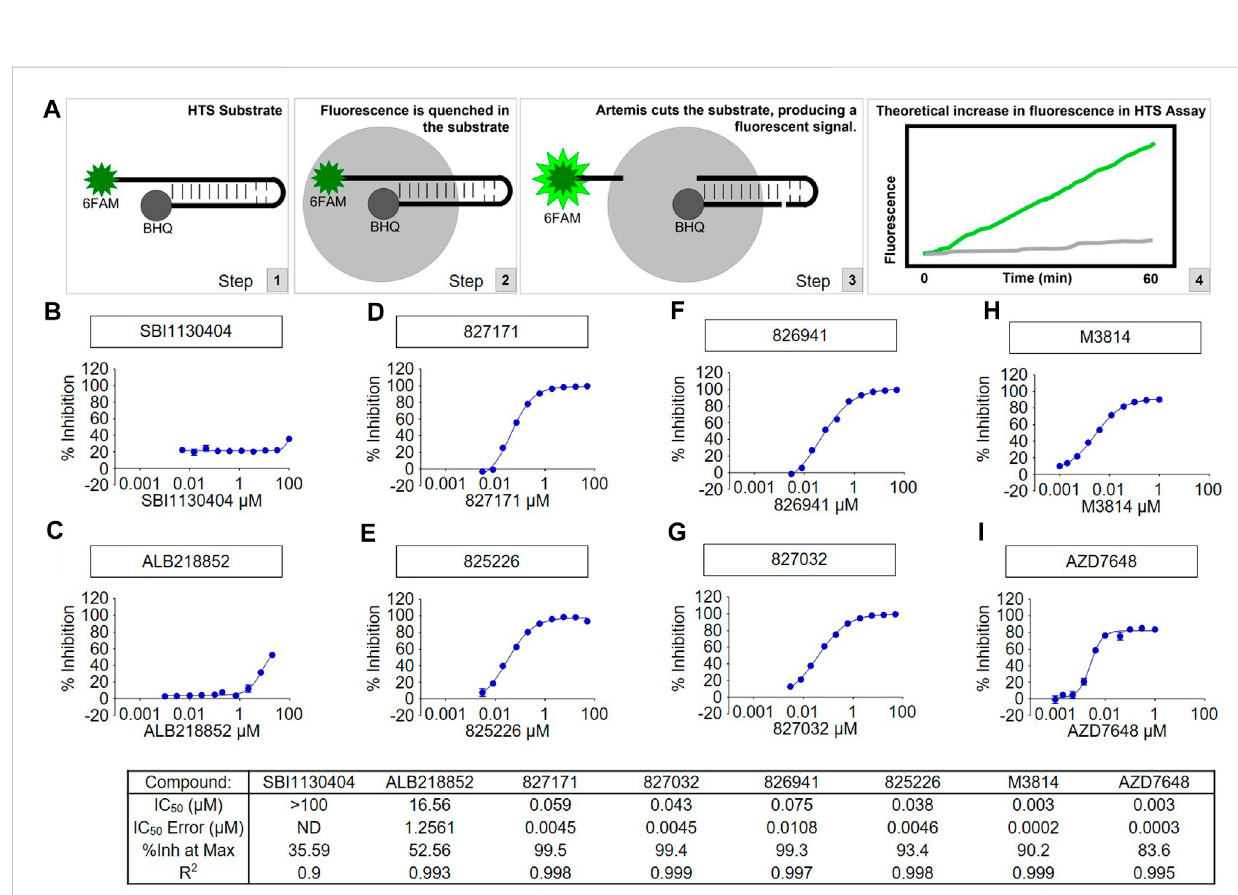
FIGURE 2 The tested compounds are potent inhibitors of the catalytic activity of puri fi ed full-length human Artemis with DNA-PKcs. (A) Schematic of High- Throughput Screening (HTS) Assay. Steps 1, 2, and 3 show the fl uorescence assay for cutting of the DNA hairpin substrate by Artems:DNA-Kcs. Artemis activity assay was optimized for development of a fl uorescent signal from the cleavage of the 6-FAM modi fi ed end of hairpin DNA (to release it from proximity to the BHQ quenching) and monitored kinetically on a Perkin Elmer Envision microplate reader with FITC fi lters (excitation wavelength = 485 nm,emission wavelength = 520 nm). Compoundsweretested inconcentration response andtheslopesof theenzymereadouts wereconvertedto percent inhibition fi t to a 4-parameter logistic curve to calculate the IC 50 of each compound. Two inactive compounds (B) SBI1130404 and (C) ALB218852,areshownforcomparison.Theassaywasusedtotestcompoundstoaidindeterminingthestructureactivityrelationshiptodevelopthrough medicinal chemistry theArtemisinhibitors (D) 827171, (E) 827032, (F) 826941 and (G) 825226.The concentration responsescurvesandcalculatedresults of the inhibitors are shown compared with known DNA-PK inhibitors (H) M3814 and (I)